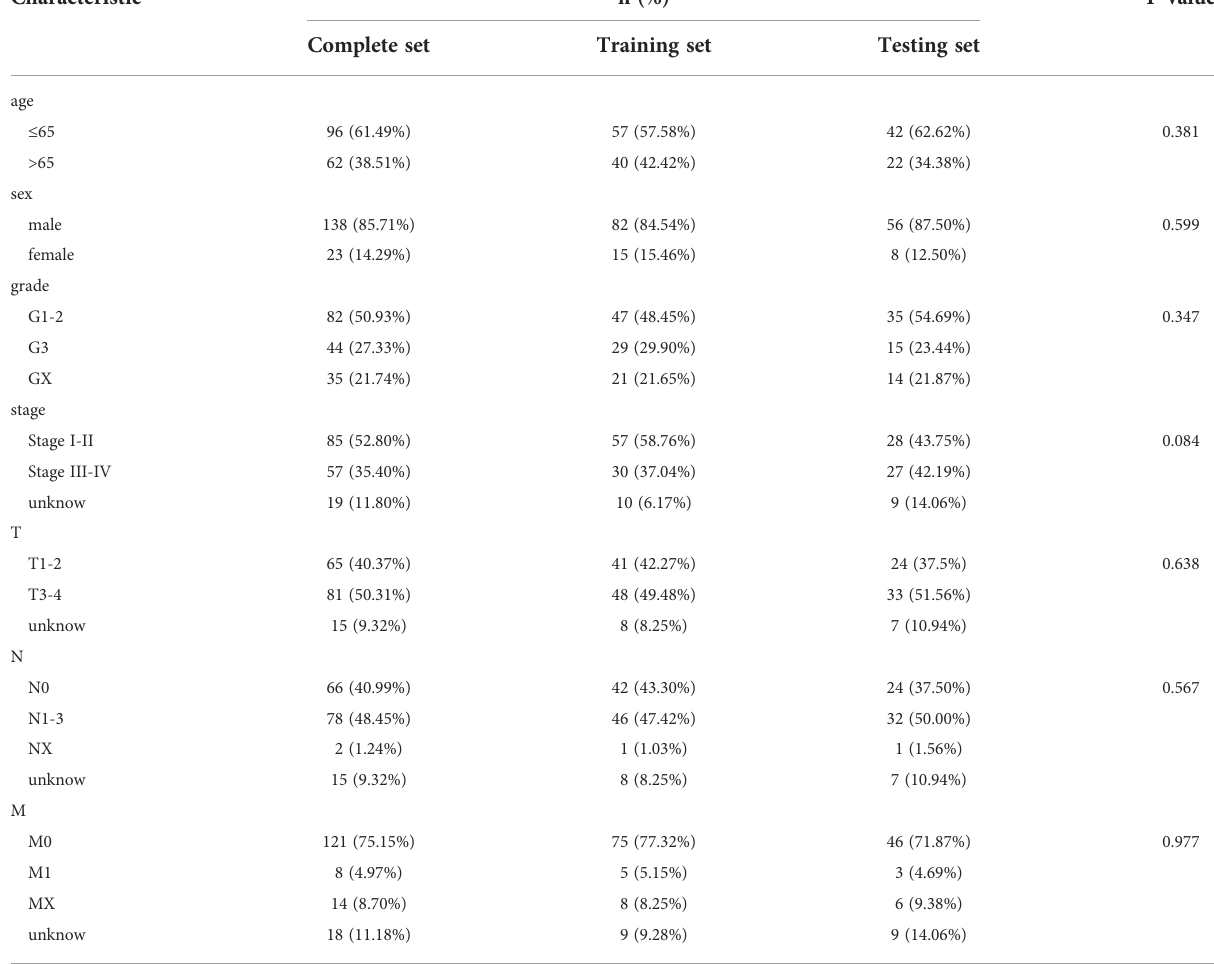
TABLE 1 Clinical characteristics of the training and testing sets of EC patients.